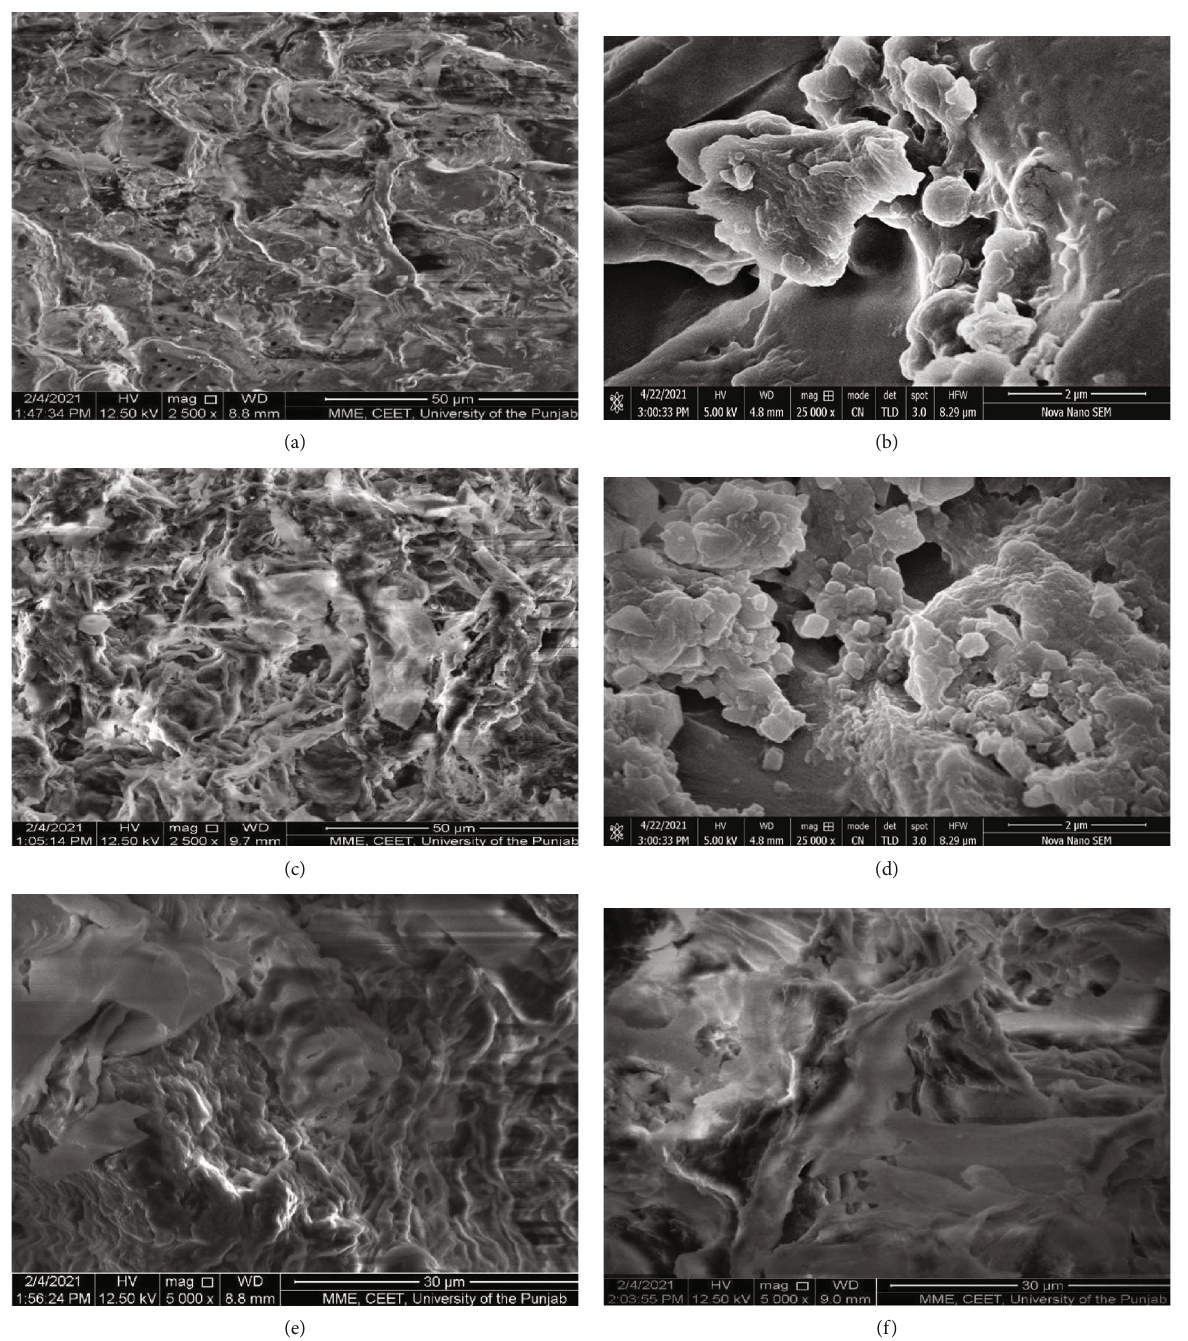
Figure 7: SEM comparison of adsorbents before and after chemical modi fi cation as well as dye loading ((a) PWM, (b) CPWM, (c) PWC, (d) CPWC, (e) CGR+ CPWM, and (f) CGR+